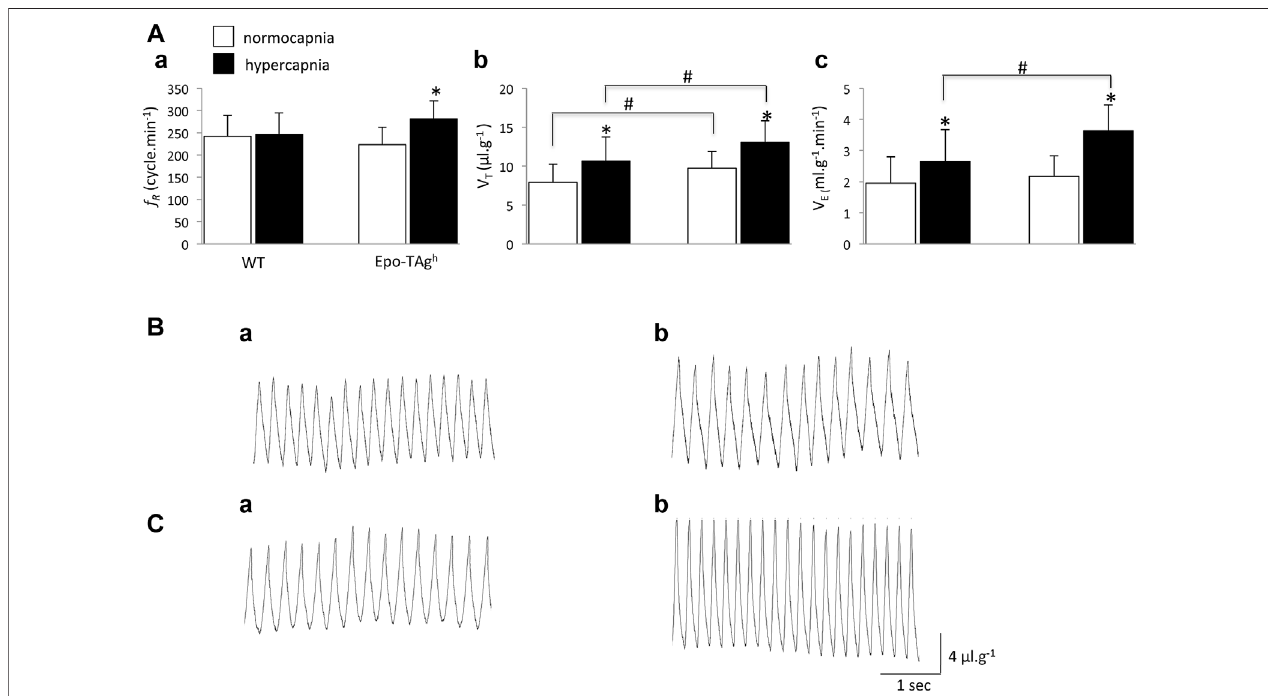
FIGURE 1 | Chronic Epo-de fi ciency led to an increase in the ventilatory response to hypercapnia with change of ventilatory pattern compared to WT mice. Histograms showing mean values of respiratory variables of WT and Epo-TAg h mice; respiratory frequency ( f R , (Aa) ), tidal volume (VT, (Ab) ) and minute ventilation (V _ E , (Ac) ) under normocapnia(white bars) and hypercapnia (black bars). Traces illustrate V _ E ofWT (B) and Epo-TAg h (C) mice under normocapnia (Ba,Ca) and hypercapnia (Bb,Cb) . Data are expressed as mean ± SD. *indicates a signi fi cant difference between normocapnia vs . hypercapnia (same strain) and # indicates a signi fi cant difference between WT vs . Epo-TAg h mice. * and # p < 0.05.